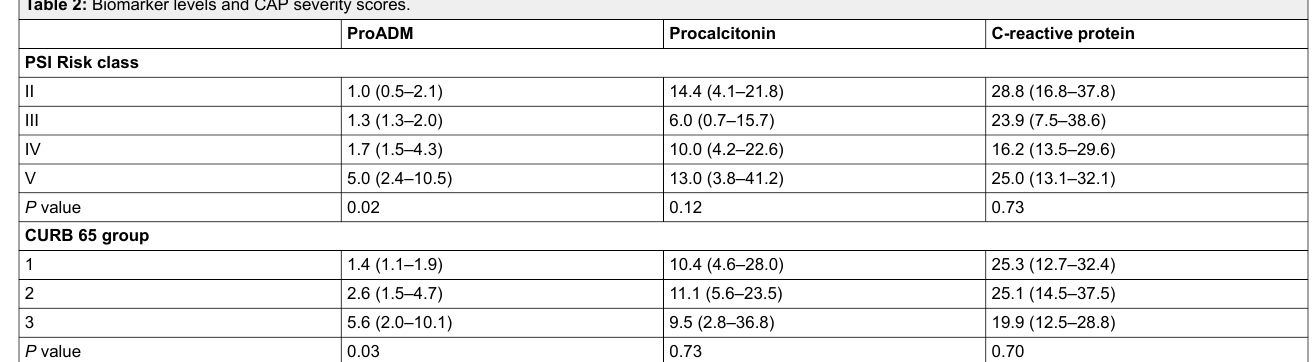
Table 2: Biomarker levels and CAP severity